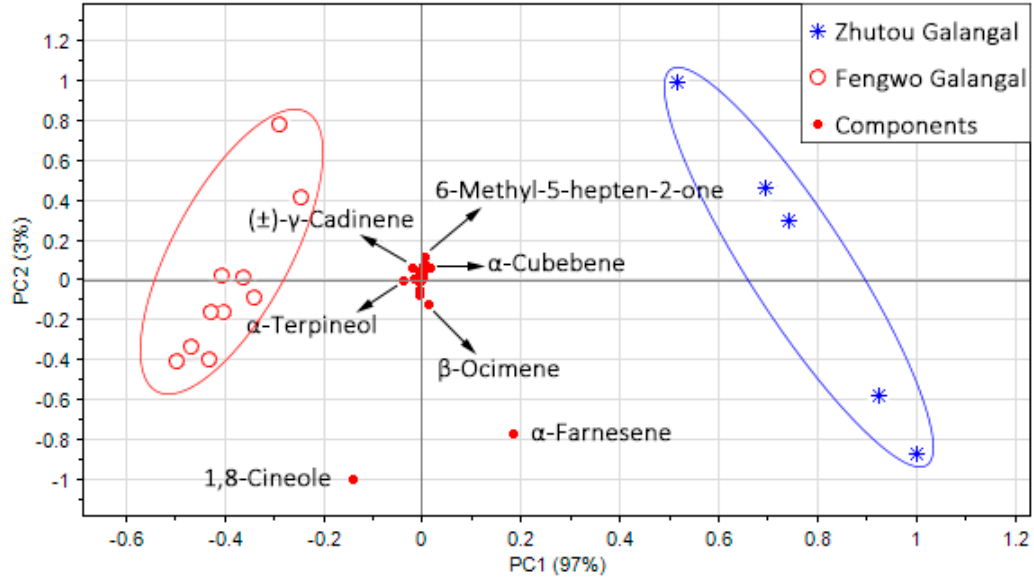
Figure 6. Bioplot of PCA based on GC-MS data of the two A. officinarum cultivars.